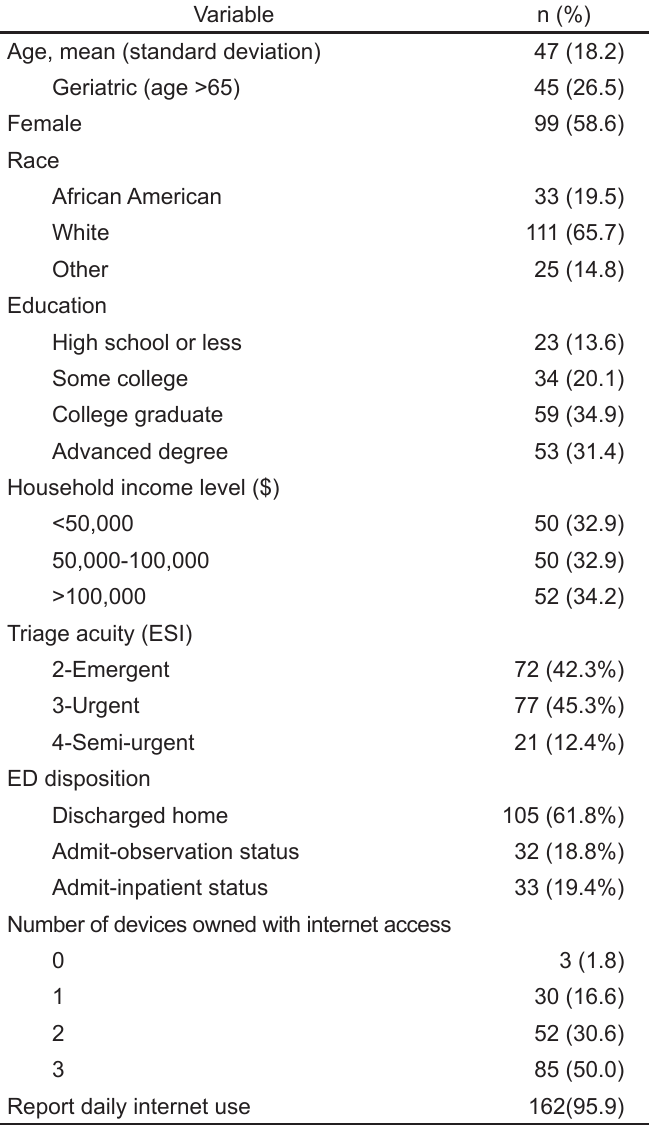
Table 1. Sample demographics in an analysis of the use of health- related Internet searches by patients prior to presentation at the emergency department